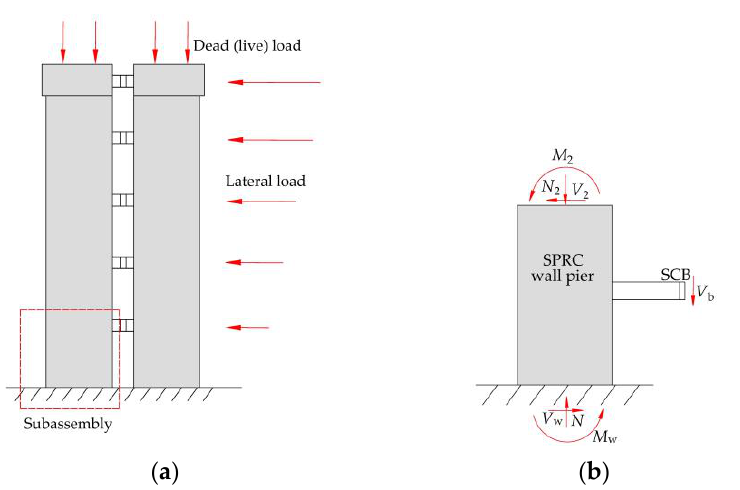
Figure 2. C-SPRC wall subassembly. ( a ) Scope of subassembly; ( b ) Boundary conditions of actual